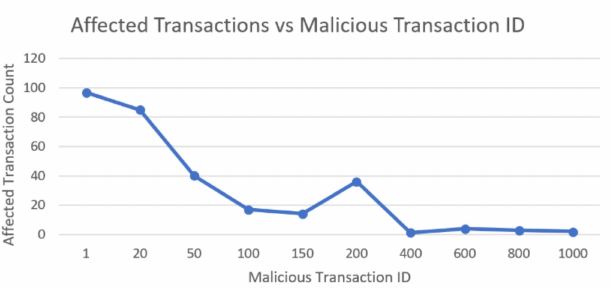
Figure 2. Number of affected transactions as a function of the malicious transaction ID.